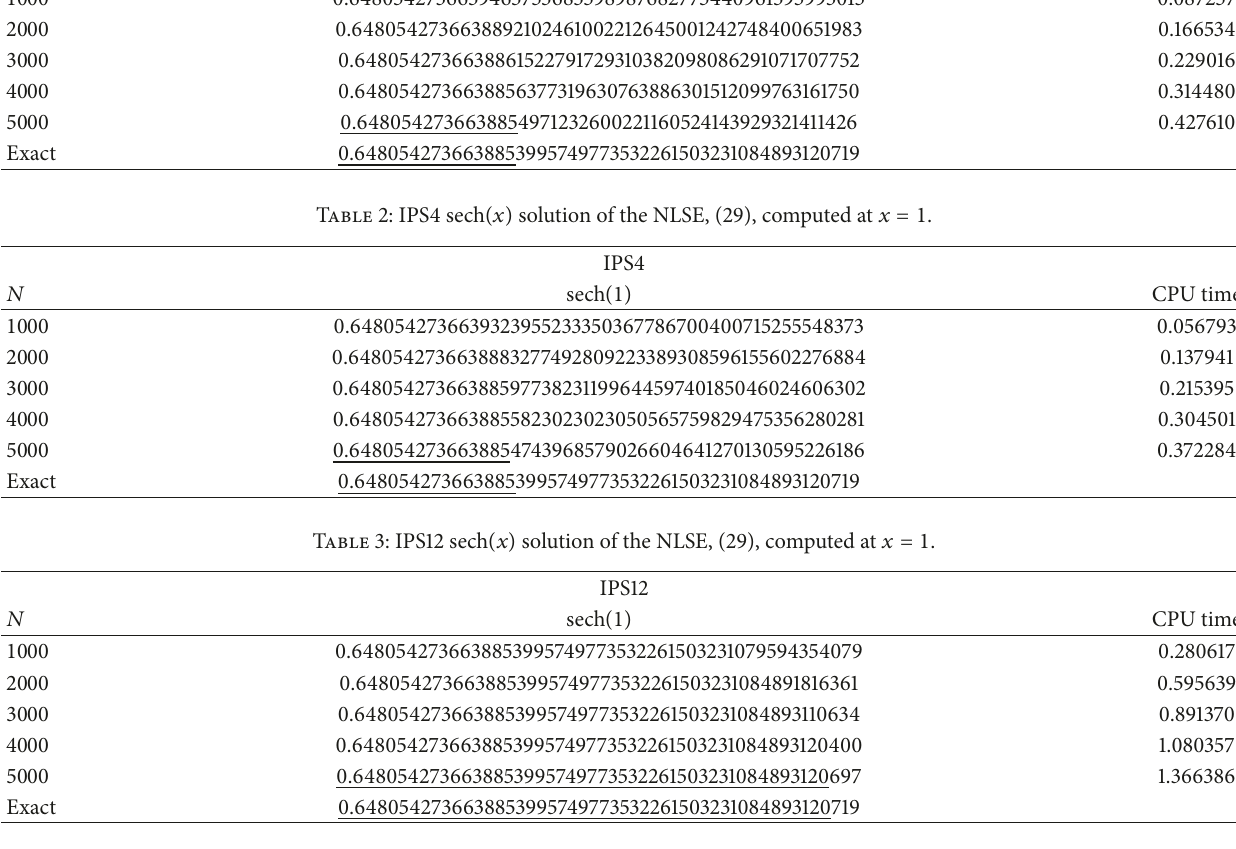
Table 4: IPS12 sech (𝑥) solution of the NLSE, (29), computed at 𝑥 = 1 , but with much less number of iterations than in Table 3.